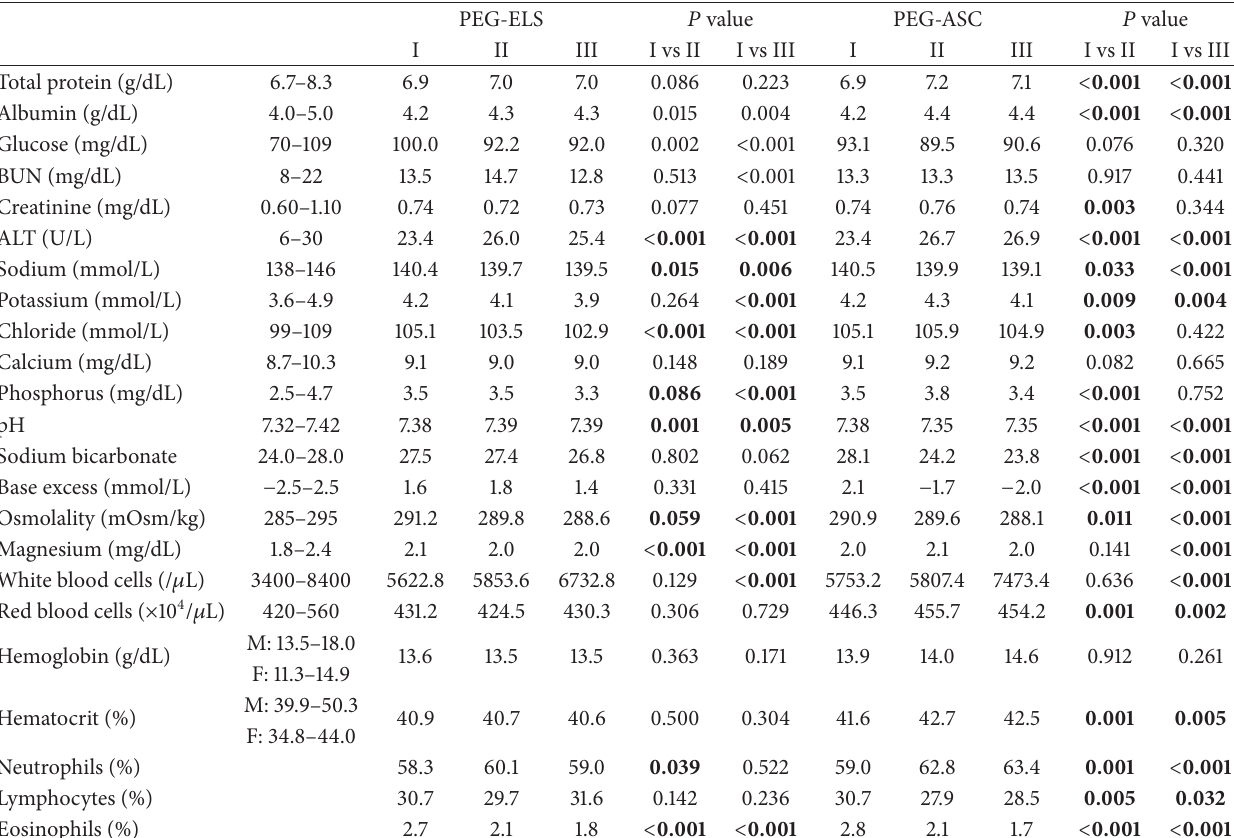
Table 4: Laboratory results comparing baseline to 3 hours and 7 hours after taking the gut lavage